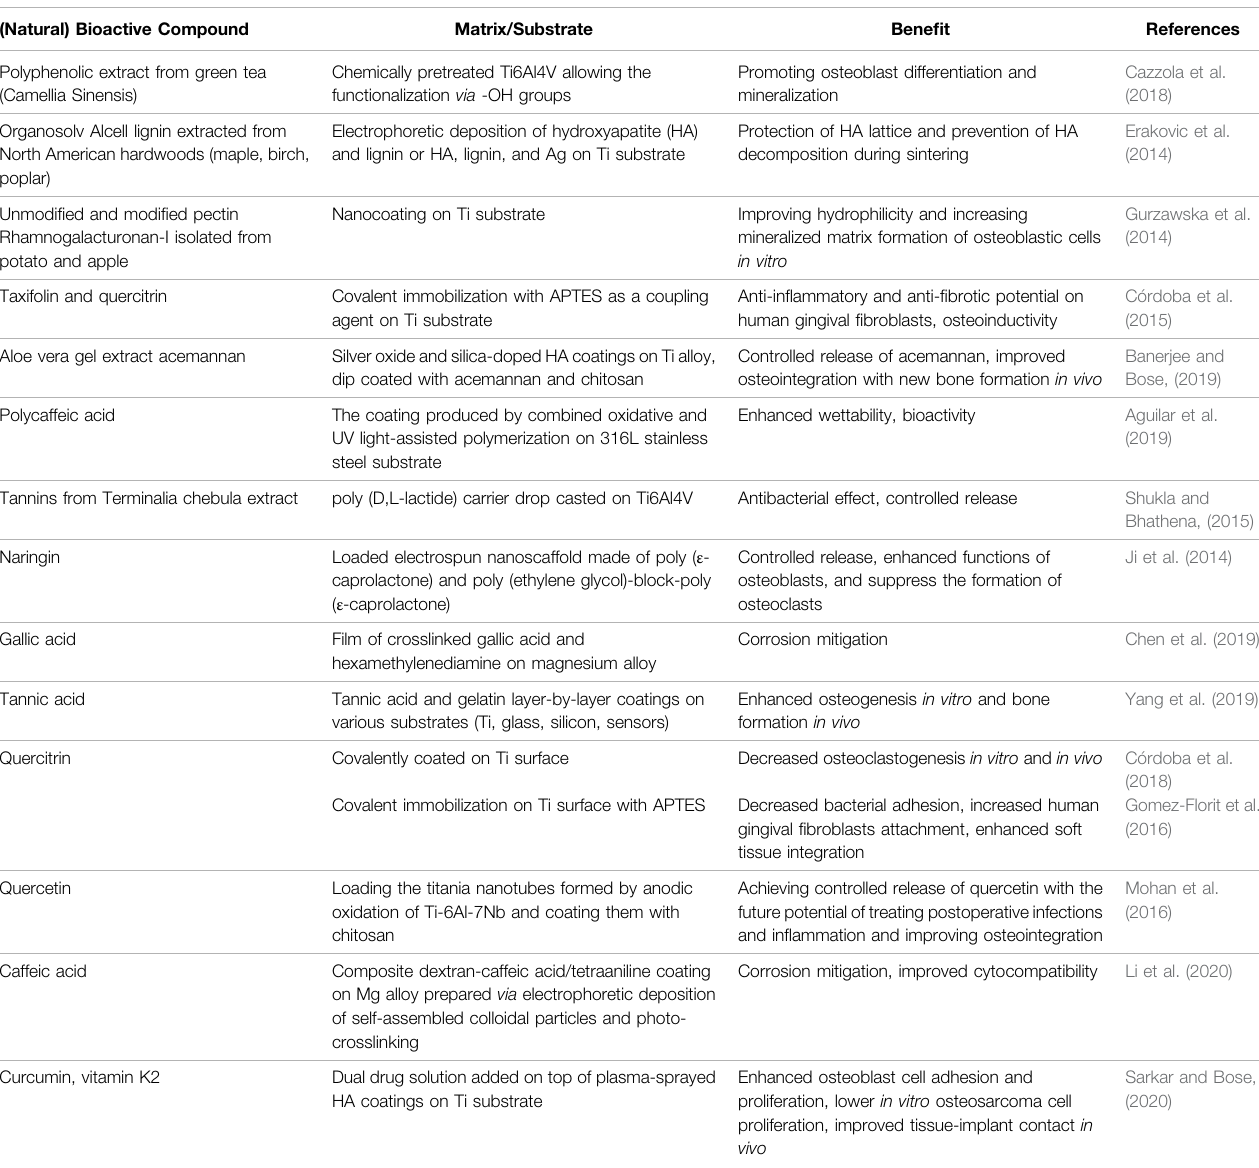
TABLE 1 | Summary of natural compounds included in bioactive coatings for implants, matrix/substrate used, and bene fi ts reported in the